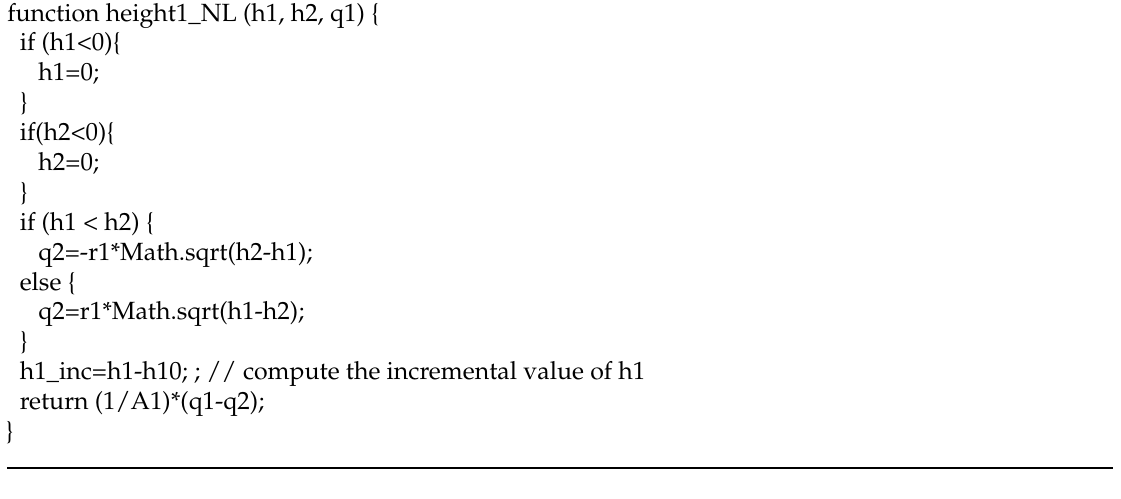
Listing 6. Function to obtain the height of the second tank h2: height2_L (nonlinear